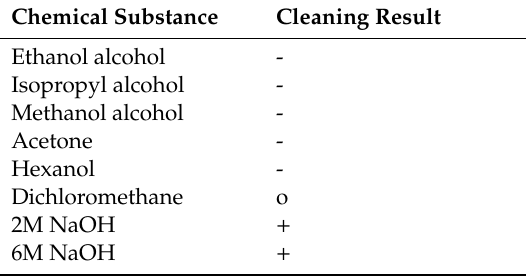
Table 3. Overview of the different cleaning solvents used and their respective effectiveness.